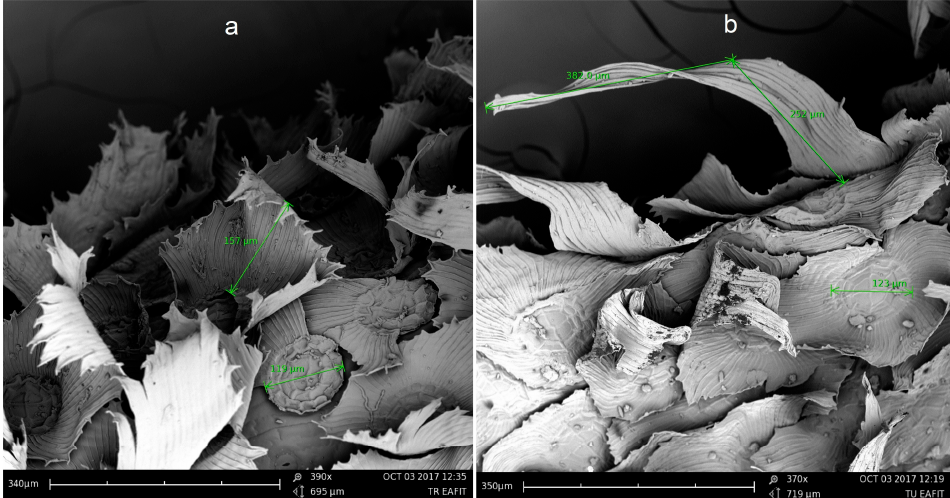
Figure 6. SEM images of Tillandsia recurvata ( a ) and Tillandsia usneoides ( b